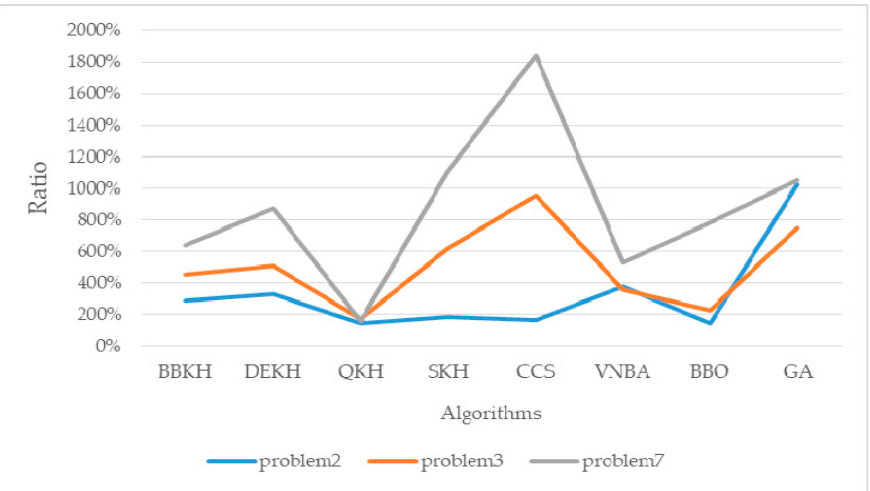
Mathematics 2020 , 8 , x FOR PEER REVIEW Figure 14. Ratio of AKQPSO over other algorithms in the second group. Figure 14. Ratio of AKQPSO over other algorithms in the second group. Figure 14. Ratio of AKQPSO over other algorithms in the second group.